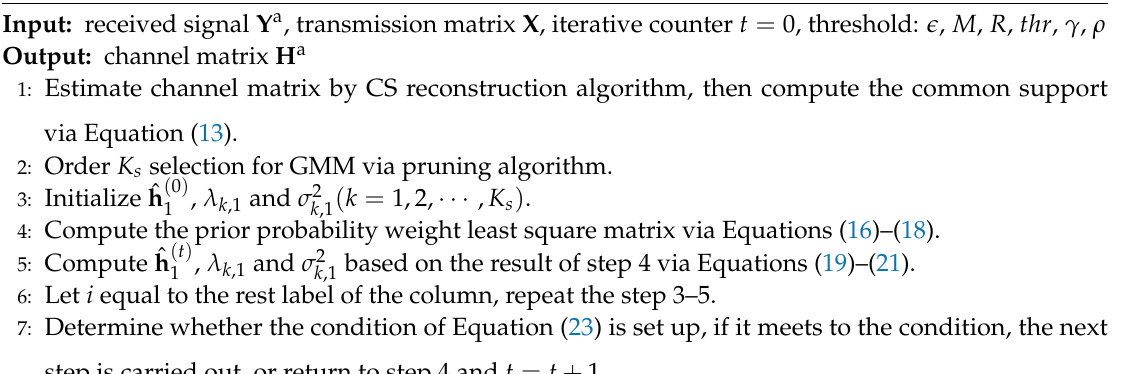
Algorithm 1 Non-Gaussian Angular Domain Sparse Channel